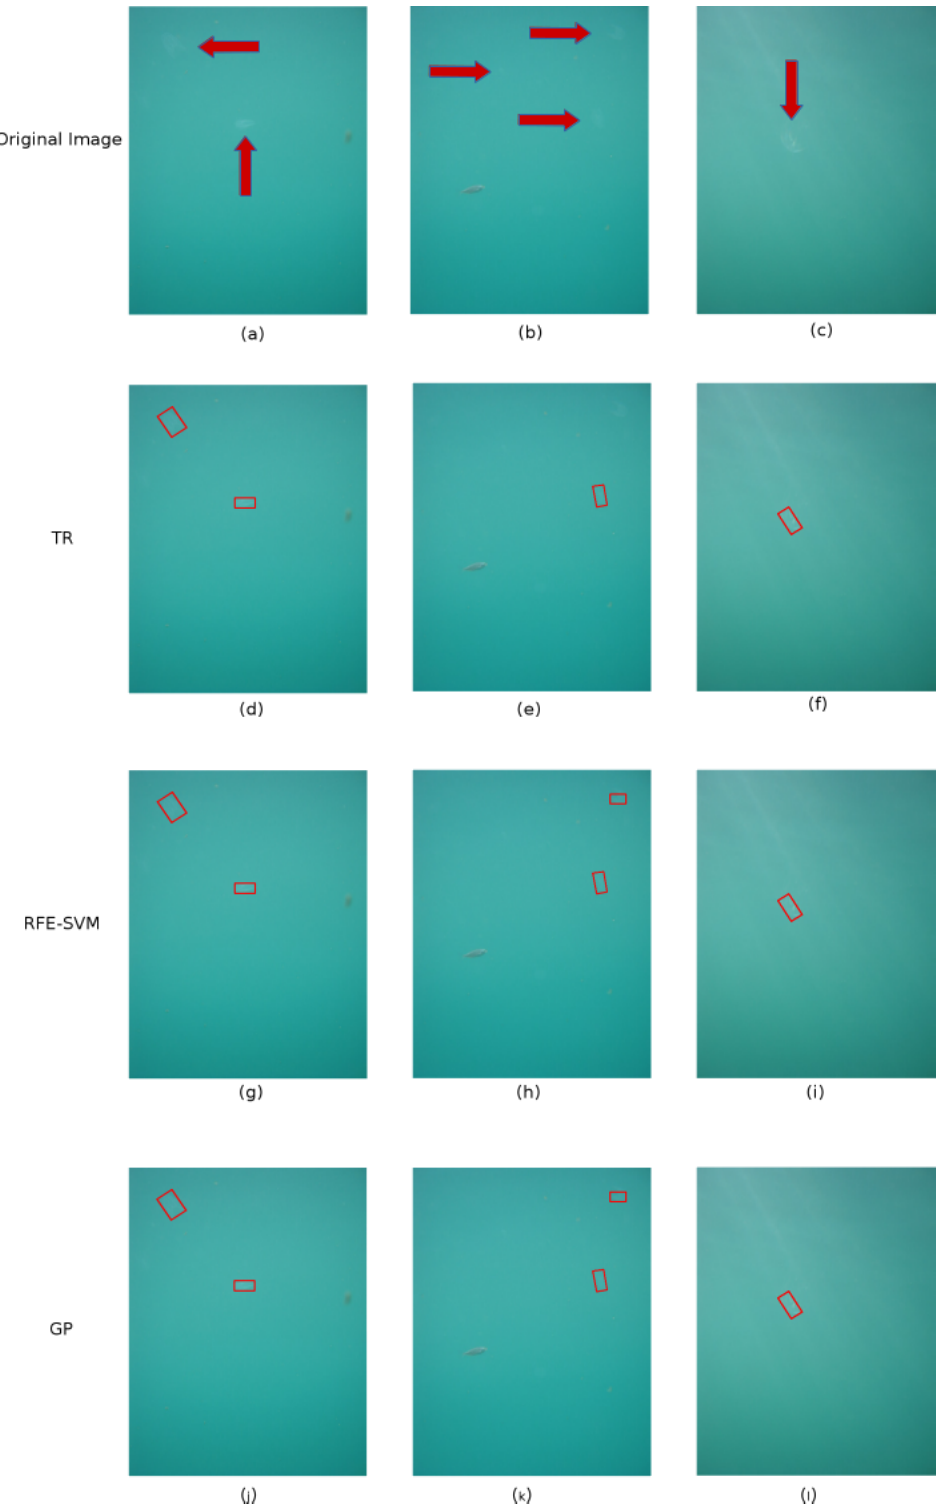
Figure 10. Some examples of the image time series collected during the gelatinuous zooplankton bloom in the Ligurian Sea and the corresponding recognition results performed by the three methods. The first row of figure show three examples of images acquired by the GUARD1 imaging system ( a – c ), where the jelly specimens are highlighted by red arrows. The last three rows present the recognition results of the three methods: TR on the second row ( d – f ); RFE-SVM on the third row ( g – i ); and GP on the fourth row ( j – l